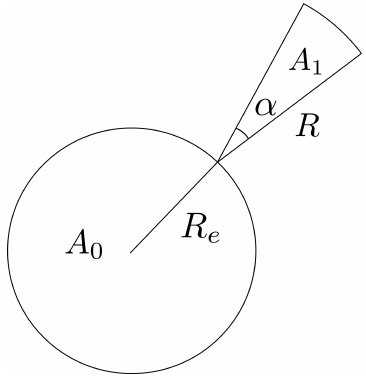
Figure 4. Cross-sectional area of NEOs hitting Earth is indicated by A 0 . The cross-sectional area of NEOs hitting the E3D beam is A 1 , with the radar antenna beam width α , and the maximum detectable range R